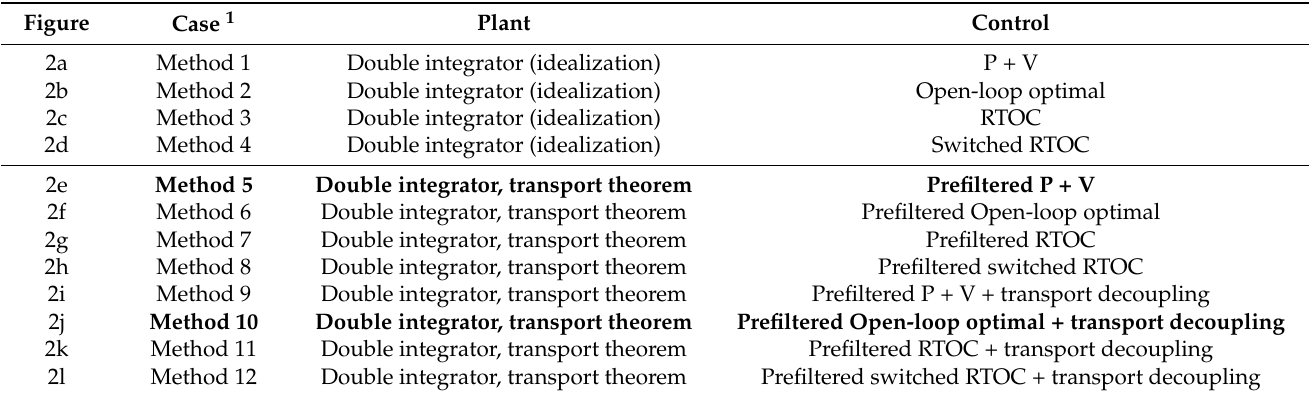
Table 6. Brief numbering of the dozen approaches studied. Short case labels (e.g., “Method 1, etc.) are used throughout Sections 2 and 3 before finally being abandoned for the sake of clarity in the presentation of short-listed results in Section 4 1